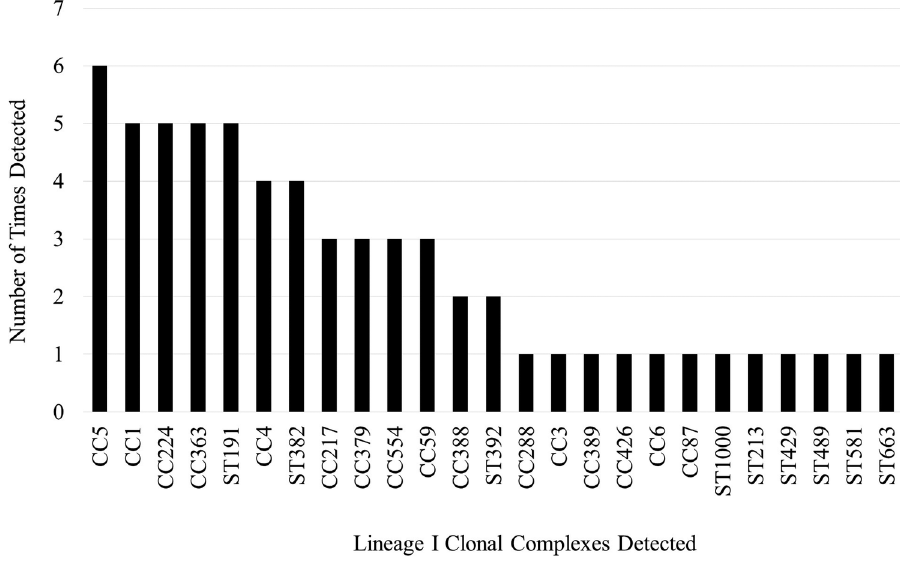
Fig 2. Frequency of detection for all lineage I clonal